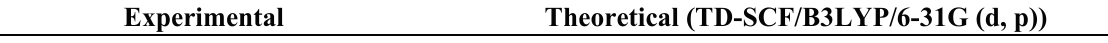
Figure 7. Combined experimental UV-vis. spectra of all compounds 1 – 4 . Table 10. Experimental and simulated (B3LYP/6-31G (d, p)) UV-vis. λ max (nm) values of title compounds 1 – 4